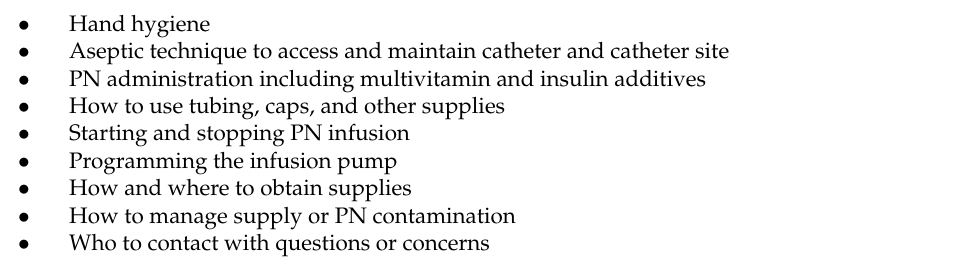
Table 3. General education topics for HPN